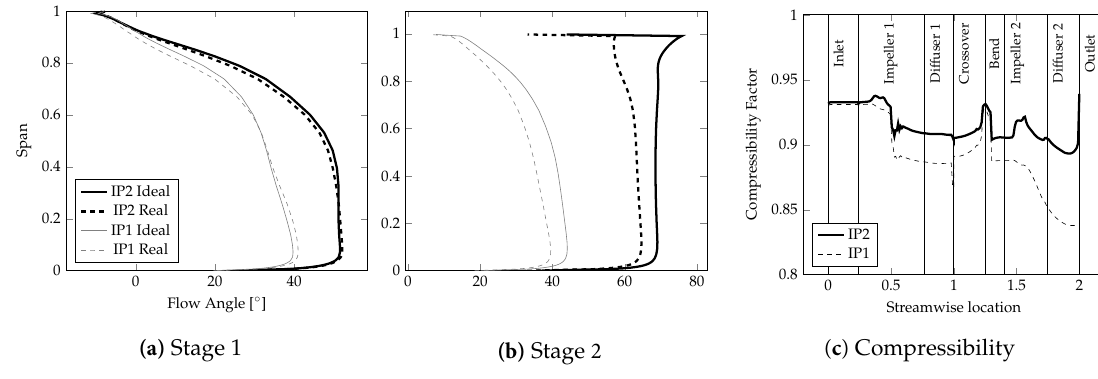
Figure 12. Flow angle and compressibility.